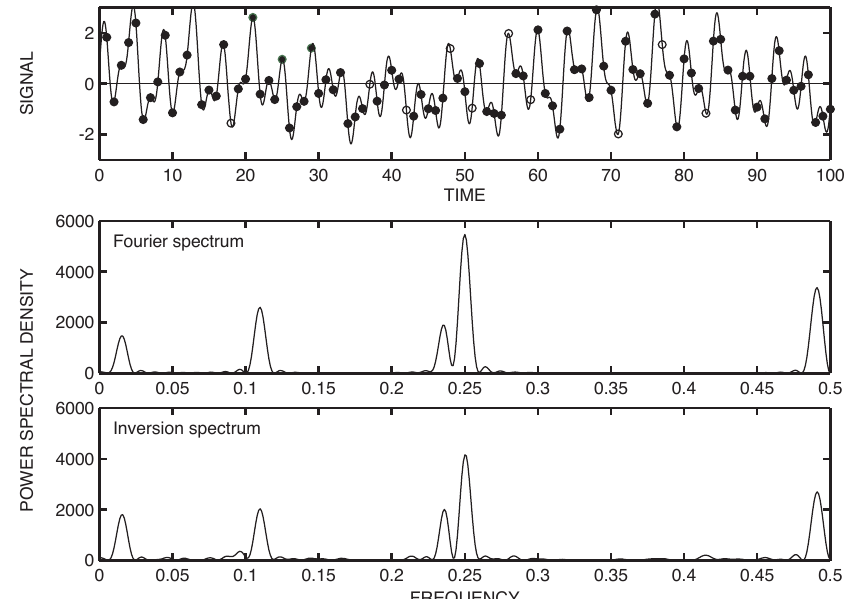
Fig. 2. Top panel: Test signal composed of sinusoidal signals at frequencies 0.015, 0.11, 0.235, 0.25 and 0.49 and respective amplitudes 0.5, 0.7, 0.5, 1.0 and 0.8. The phases are chosen randomly. The number of samples is 100 and they are indicated by markers. Middle panel: Power spectral density calculated from all samples in the top panel by means of Fourier transform. Bottom panel: Power spectral density calculated from the 90 samples indicated by filled dots in the top